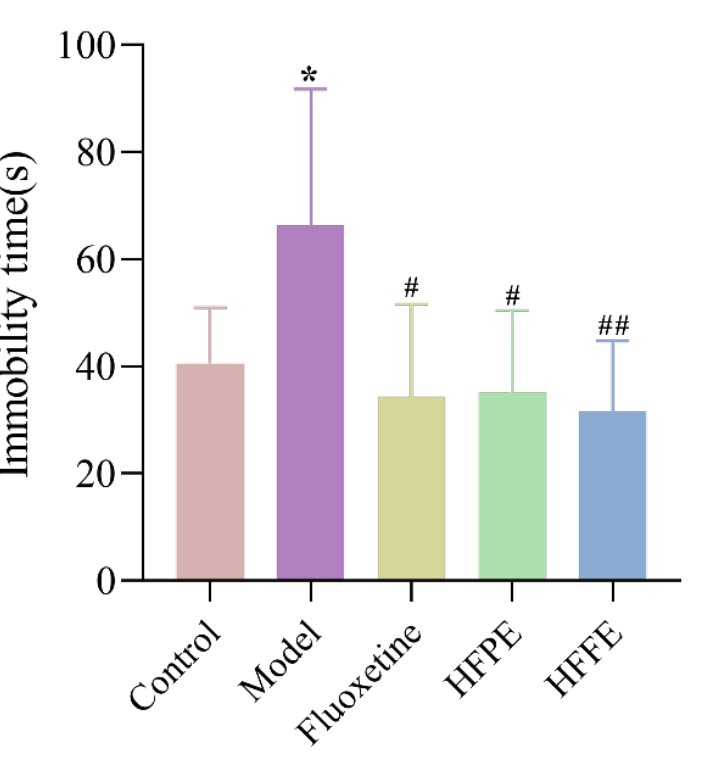
Figure 7. Effects of HFPE and HFFE on FST. Results were represented as mean ± SD ( n = 10). * p < 0.05 compared with the control group, # p < 0.05 and ## p < 0.01 compared with the model group.